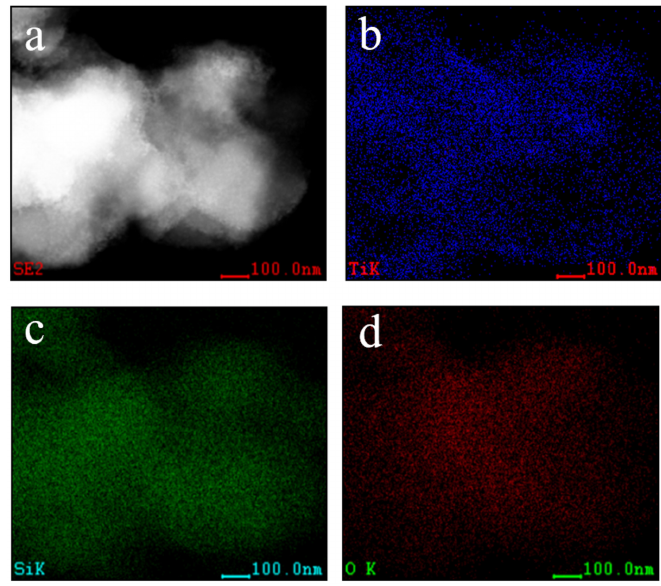
Figure 7. EDX elemental mapping investigation of ( a ) TiO 2 -SiO 2 ( b ) Ti; ( c ) Si; ( d ) O. The full XPS spectra of SiO 2 and TiO 2 -SiO 2 were shown in Figure 8a and several peaks corresponding to Si, C, Ti, and O elements could be observed. Figure 8b showed the XPS spectrum of O1s of the sample SiO 2 . The characteristic peak appeared at 532.3 eV and could be assigned to the binding energy of O 1s in Si-O-Si. The peak centered at around 103.3 eV in Figure 8c confirmed the presence of the Si element in SiO 2 . A Ti 2p XPS spectrum of TiO 2 -SiO 2 in Figure 8d was fitted into three peaks. The peaks located at 458.1 eV and 463.4 eV were assigned to Ti 2p3/2 and Ti 2p1/2 of TiO 2 , respectively. A minor peak at 455.46 eV might be attributed to the low valence states of Ti [38]. The coating of TiO 2 exerted a great influence on the O 1s XPS spectrum (Figure 8e), which could be split into three peaks. The peak located at 529.6 eV and 532.7 eV were related to Ti–O–Ti and Si–O–Si. The peak at 532.0 eV could be assigned to the binding energy of the Si-O-Ti species, indicating the bonding of TiO 2 to SiO 2 [39]. Figure 8f showed the XPS spectrum of Si 2p of the sample TiO 2 -SiO 2 . There were two characteristic peaks of Si 2p located at 100.6 eV and 103.3 eV, showing that the coating of TiO 2 had an effect on the binding energy of the Si element.